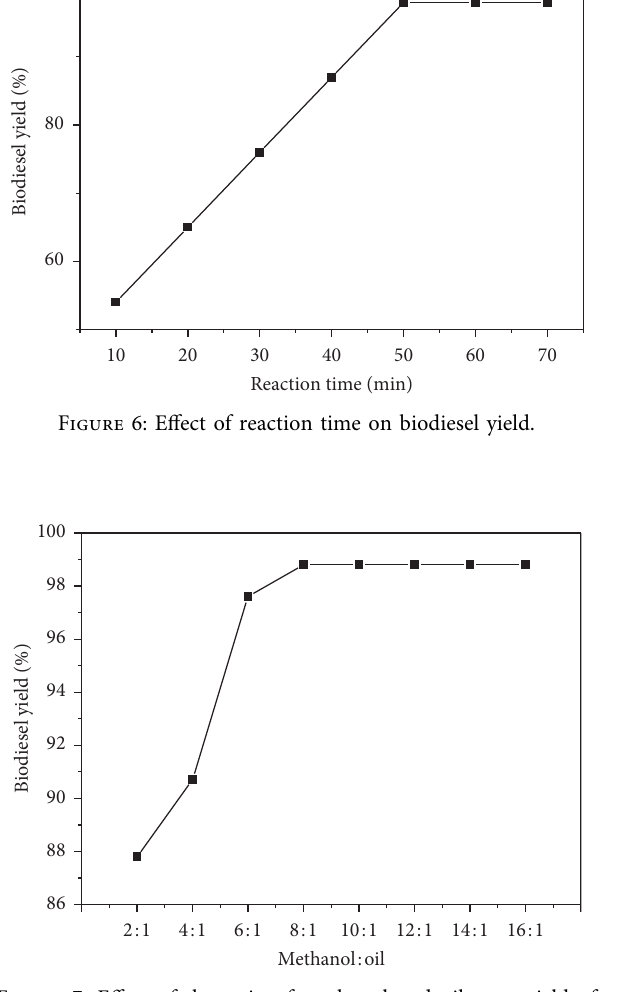
Figure 7: Effect of the ratio of methanol and oil on a yield of biodiesel.